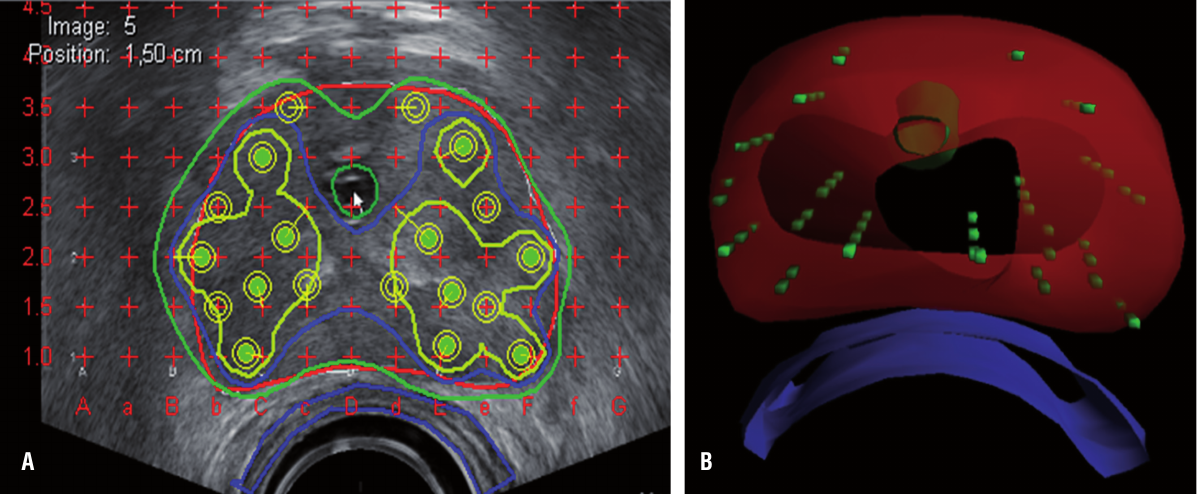
Figure 4 - Left: Image of intra-operative planning on transrectal ultrasound. The colored lines mark the different areas where the radiation dose is similar. Urethra and rectum are marked to keep the radiation dose as low as possible in these regions. Right: 3D reconstruction of the seeds after